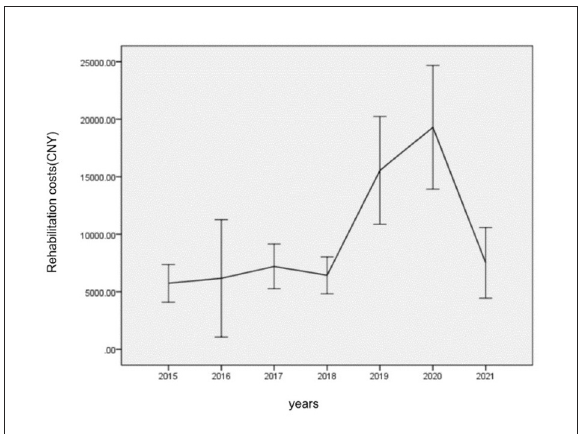
FIGURE4 Distribution of rehabilitation costs stratified by year of the study